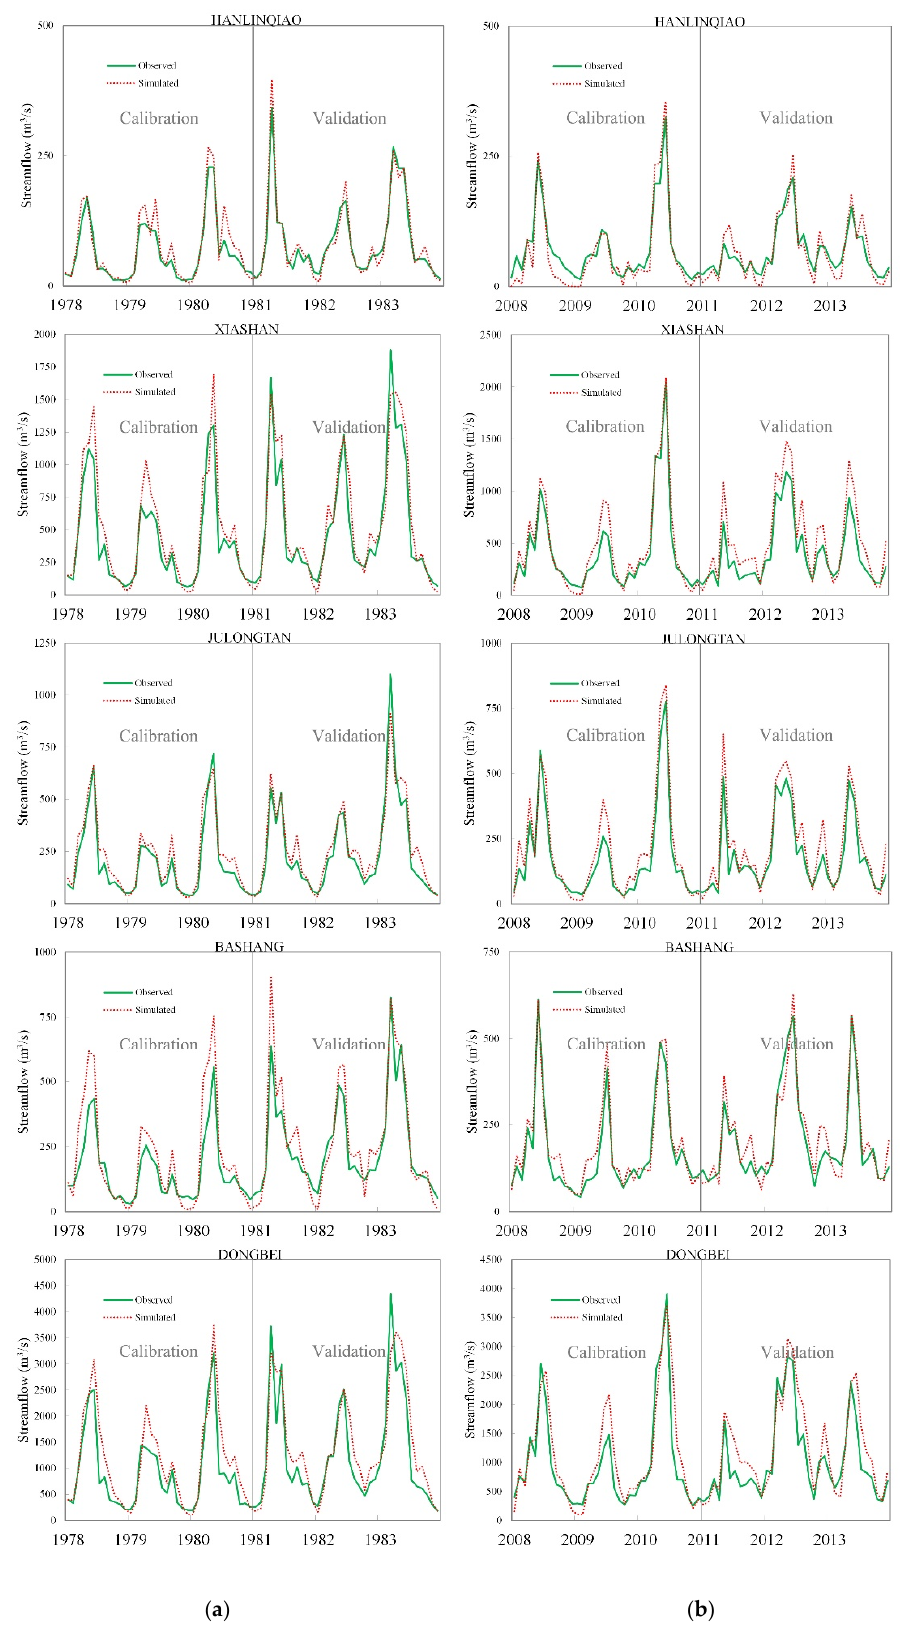
Figure 3. Comparison of 1980 ( a ) and 2010 ( b ) observed and simulated runoff at five hydrological stations (Hanlinqiao, Xiashan, Bashang, Julongtan, and Dongbei) under land-use scenarios.